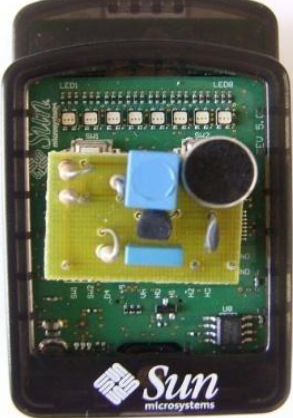
Figure 6. Sun SPOT node with the analog circuit.